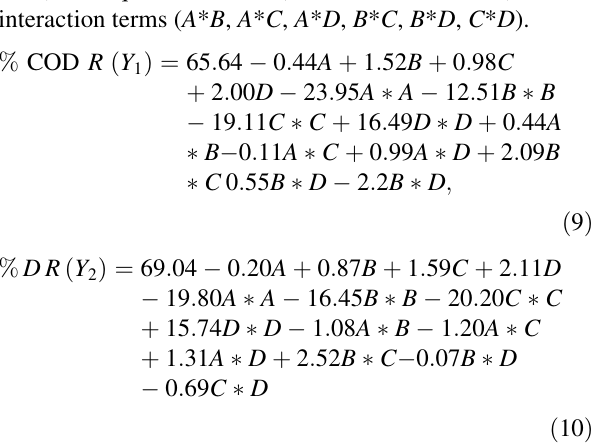
Table 2 Levels of the parameters studied in the